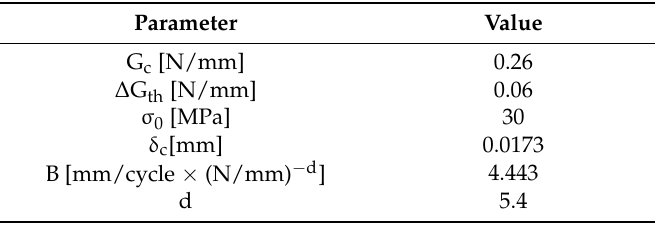
Table 1. Cohesive zone model (CZM) and fatigue crack growth (FCG) parameters that are not varied in the simulations, from 21.